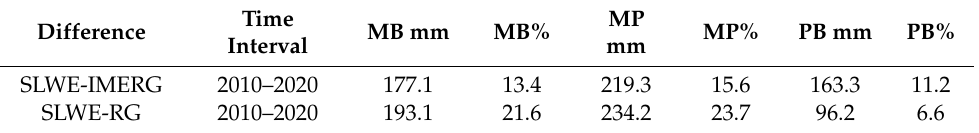
Table 3. Average annual difference (2010–2020) between snow level water equivalents (SLWE) and IMERG data and average annual difference (2010–2020) between SLWE and rain gauges data (RG); the values are given in mm (MB mm; MP mm; PB mm) and as a percentage of the annual average rainfall during the period 2010–2020 (MB%; MP%; PB%).